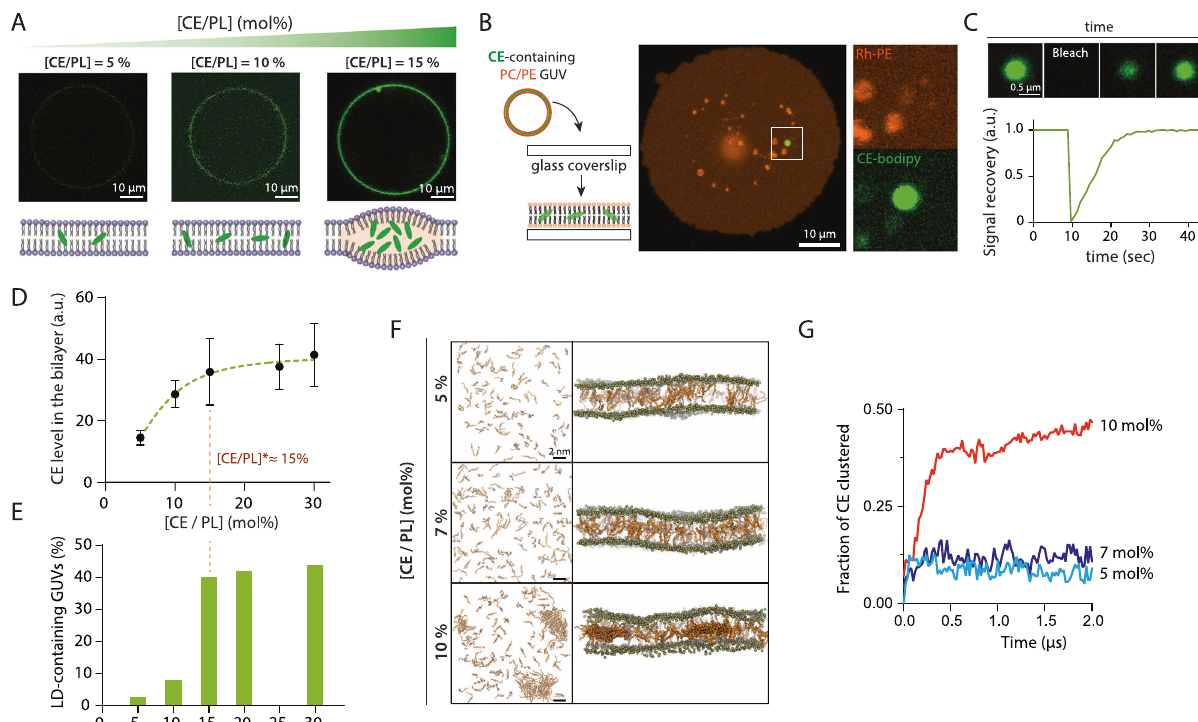
Fig. 3 | CEs condense into droplets in model membranes. A GUVs were made with different concentrations of CE (here, cholesteryl oleate) and imaged under confocal microscopy. Top: images of gradually CE-concentrated GUVs. CE con- densatesstartedappearingfromtheconcentrationof15mol%.Bottom:Schematic representationofgraduallyincreasingCEconcentrationwithinGUVbilayer. B Left: Schematic representation of GUV splashing on a bare glass coverslip. Right: microscope image of a splashed GUV, appearing fl at on the glass surface. CE condensates were still visible and immobilized. C Signal recovery in a totally bleached CE condensate from splashed GUV as shown in B . The signal was nor- malizedbytheinitial fl uorescencesignal. D Quanti fi cationoftheamountoffreeCE in the membrane by measuring the CE/PL fl uorescence ratio in splashed GUVs as shownin C .Points:Mean±SD,5 – 10GUVsperexperimentalpoint. E Quanti fi cation